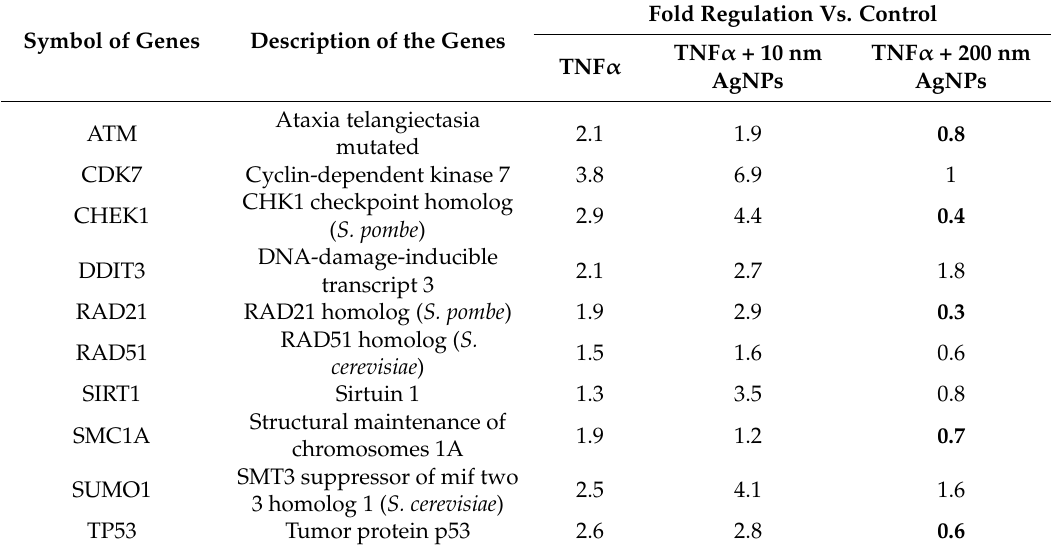
Table 1. Induction of mRNA expression of DNA-damage genes in NCI-H292 cells.